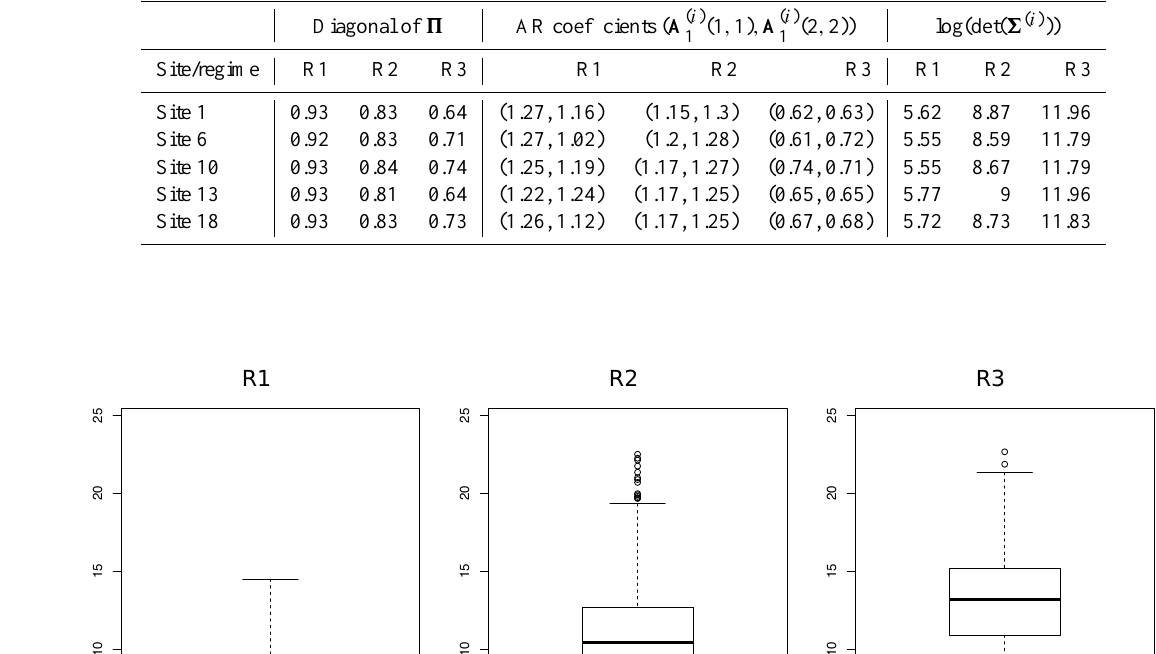
Table 1. Parameter values obtained when fitting a H-MS-VAR at the different sites: diagonal of the transition matrix (cid:53) , coefficients of the autoregressive model in each regime, and logarithm of the determinant of (cid:54) ( i ) .